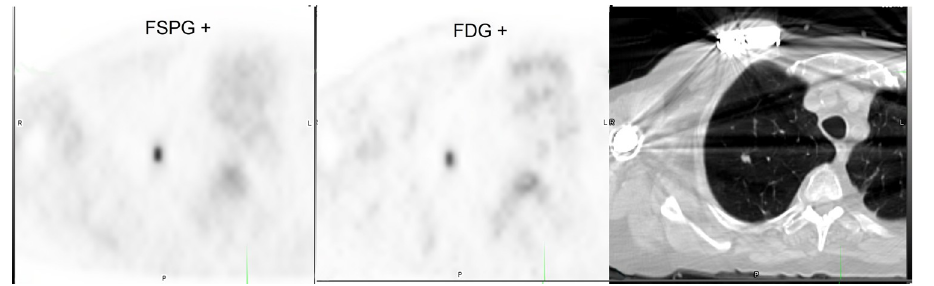
Fig 3. Subject with positive 18 F-FSPG (SUVmax 3.5) and 18 F-FDG (SUVmax 7.4) PET/CT.